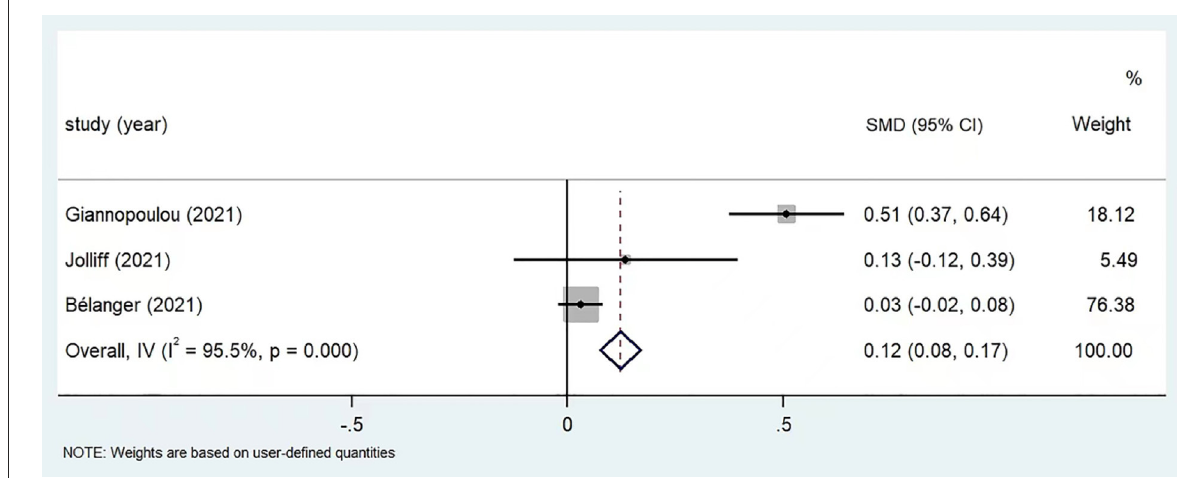
FIGURE2 Meta-analysis of anxiety score before and post COVID-19 in children and adolescents ( n = 3).